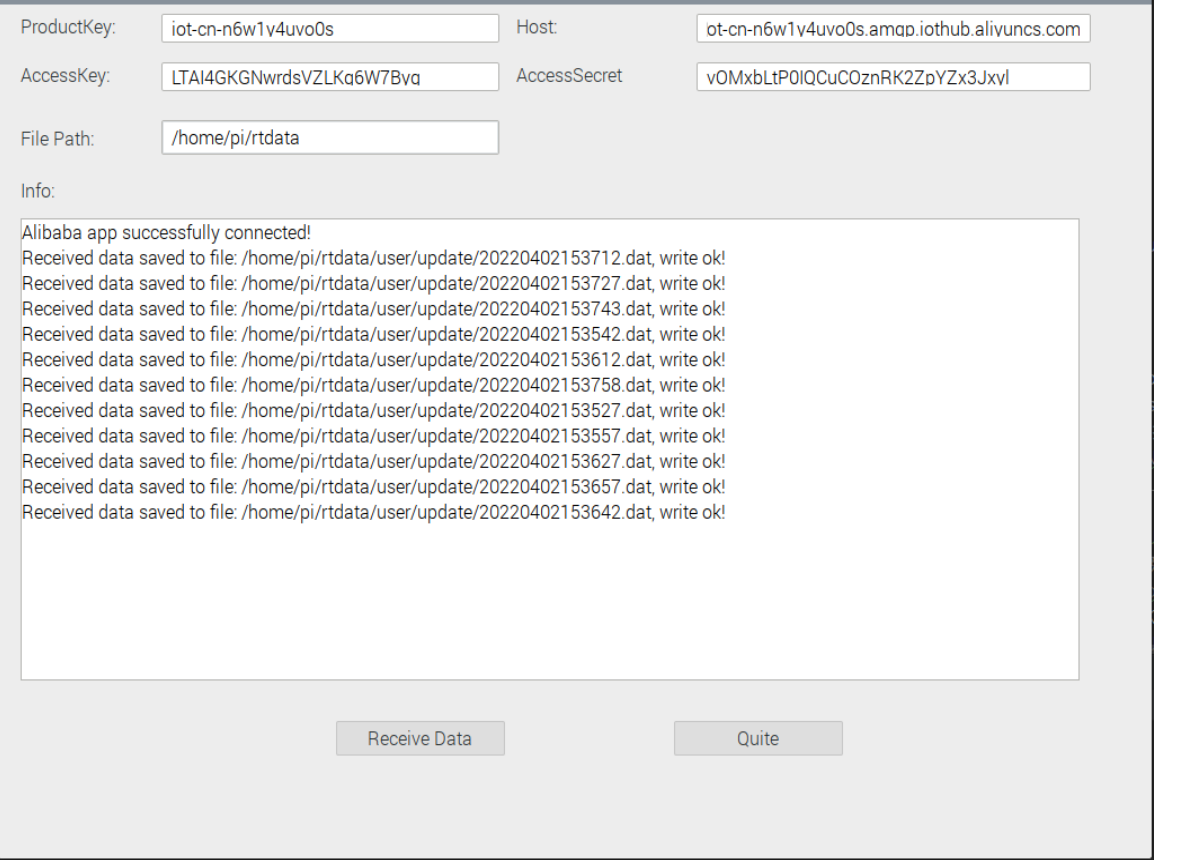
Figure 8. Screenshot of the dashboard designed using the wxPython library. Subscribed data were downloaded in real time using this application by clicking on the “Receive Data” button. The “Quite” button terminates the data transmission.